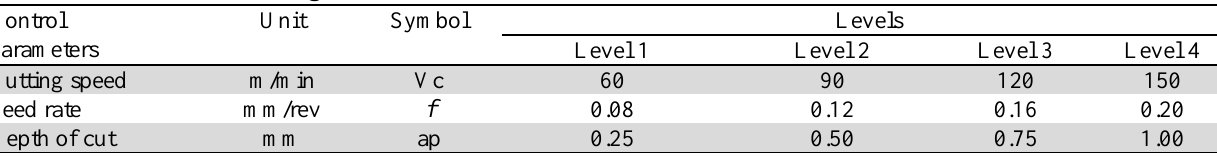
Attribution levels of cutting